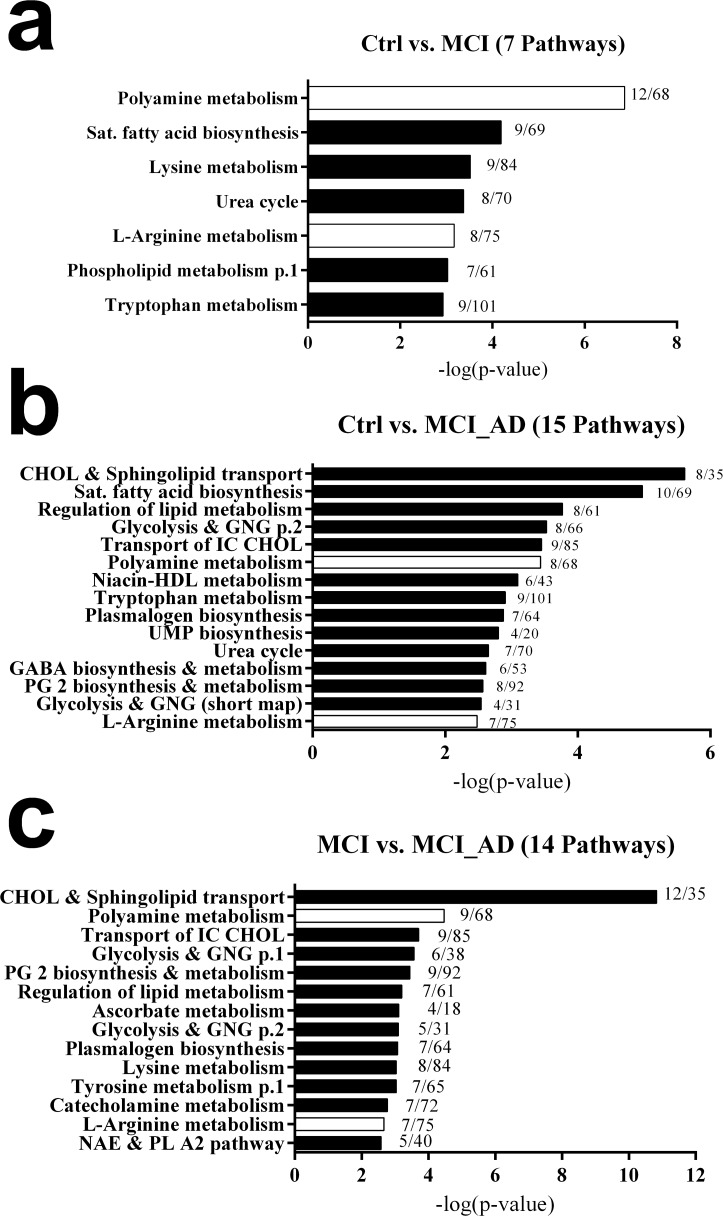
Pathway Enrichment Analysis.Altered metabolic pathways and process networks in plasma of (a) Ctrl vs. MCI, (b) Ctrl vs. MCI_AD and (c) MCI vs. MCI_AD subjects were uncovered using Metacore. The significance of the pathways was evaluated using P values and a false discovery rate of <0.05. Bars in white are pathways implicated across all three comparisons. Ratios are the number of significantly altered metabolites in the pathway against the total number of metabolites in that pathway.